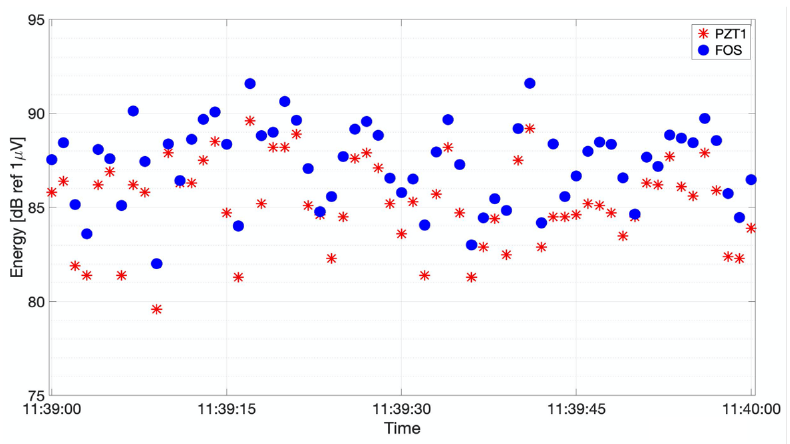
Figure 12. The evaluated energy during 1 min of the fatigue growth crack test at L = 100 mm crack length.